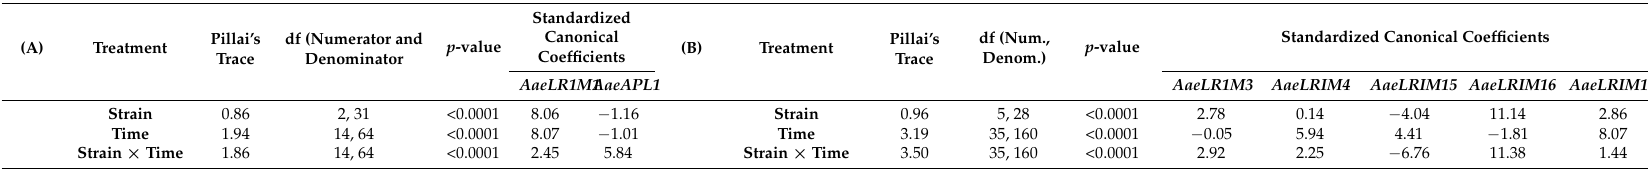
Table 4. ( A ) MANOVA results for strain and time effects of the AaeLRIM1 and AaeAPL1 RNA profile in response to Zika virus infection of Ae. aegypti . ( B ) MANOVA results for strain and time effects of paralogues of the AaeAPL1 RNA profile in response to Zika virus infection of Ae. aegypti